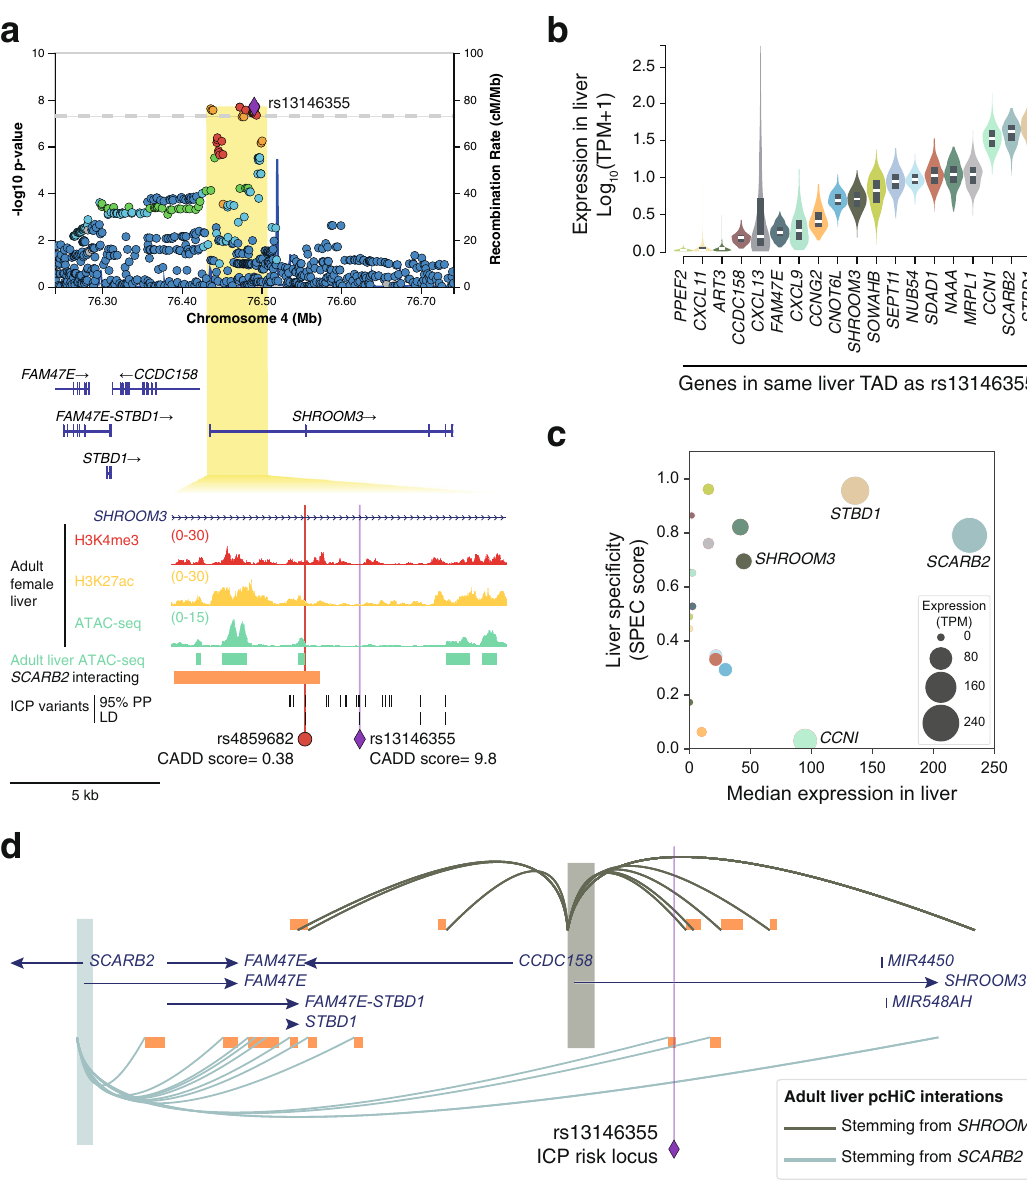
Fig. 7 Tissue-speci fi city and 3D chromatin conformation analyses prioritize SCARB2 as an ICP susceptibility gene. a LocusZoom 86 plot showing the association signal at SHROOM3 . The LocusZoom plots are as per Fig. 3 and association testing was performed as described in Fig. 1. All epigenomic and transcriptomic datasets shown were retrieved from ENCODE 18 . Adult liver ATAC-seq peaks track (green regions) corresponds to regions accessible in at least two out of four ENCODE adult liver ATAC-seq (see “ Methods ” ). 95% PP ICP variants, variants within the 95% genetic credible set in the ICP